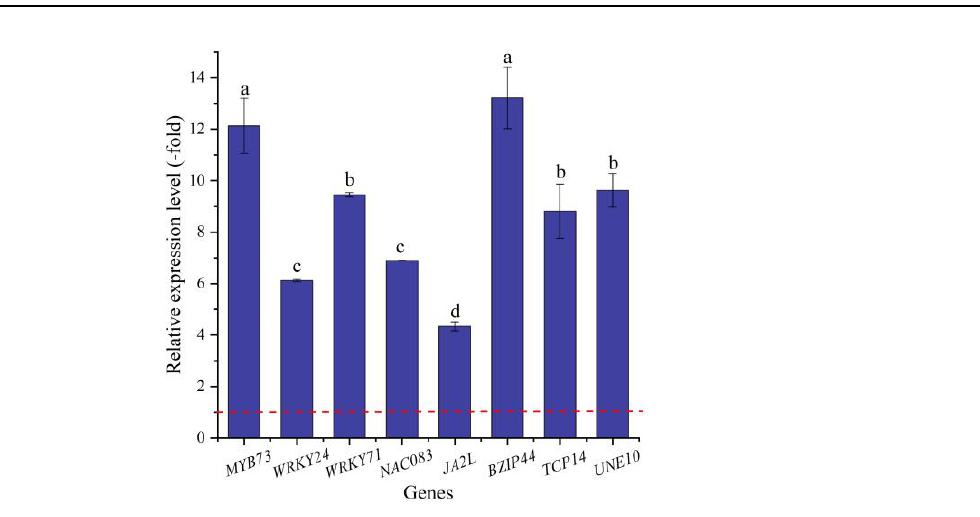
Figure 10. The RELs of TFs directly associated with stress response and seed germination in A. venetum seeds at 300 mmol/L NaCl vs. CK (mean ± SD, n = 3). Different letters represent a significant difference ( p < 0.05) among different genes. The red dotted line differentiates UR (>1) and DR (<1).